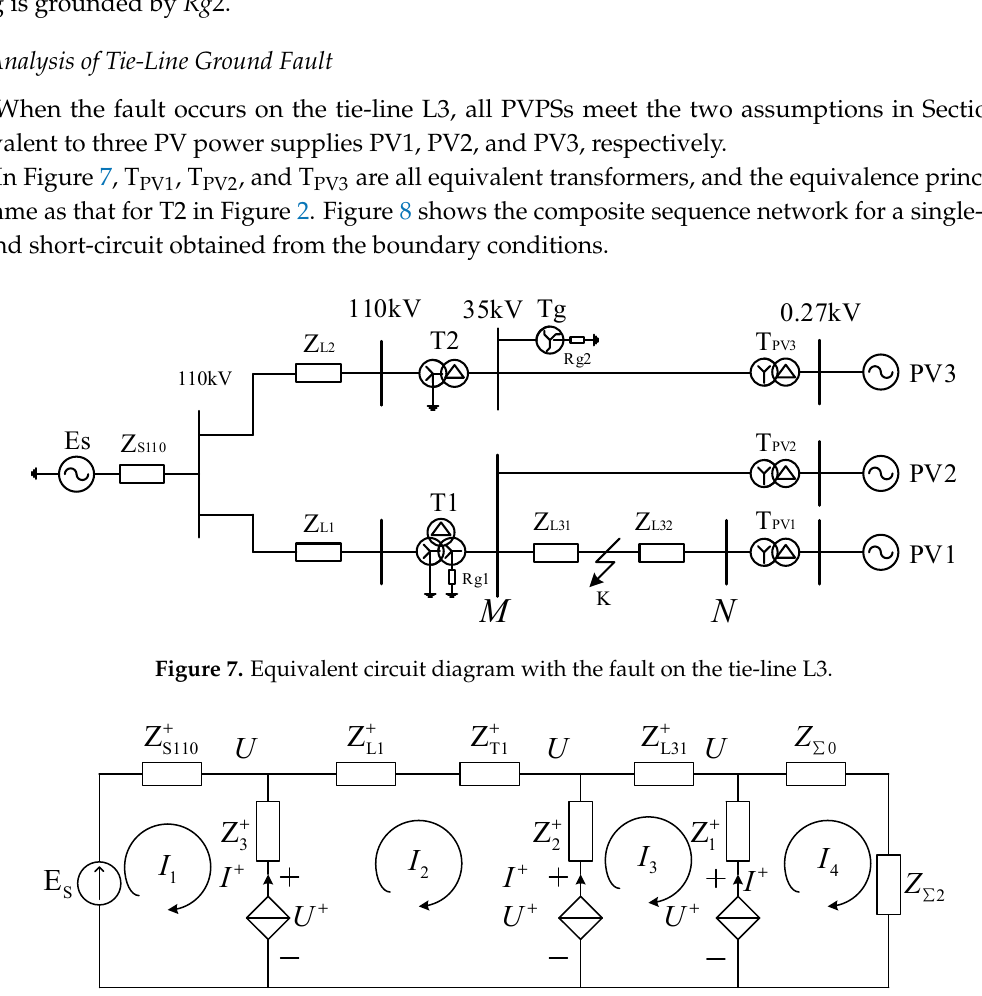
Figure 8. Composite sequence network for a single-phase ground short-circuit on L3.